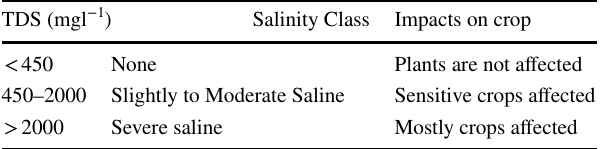
Table 4 TDS-based soil classification